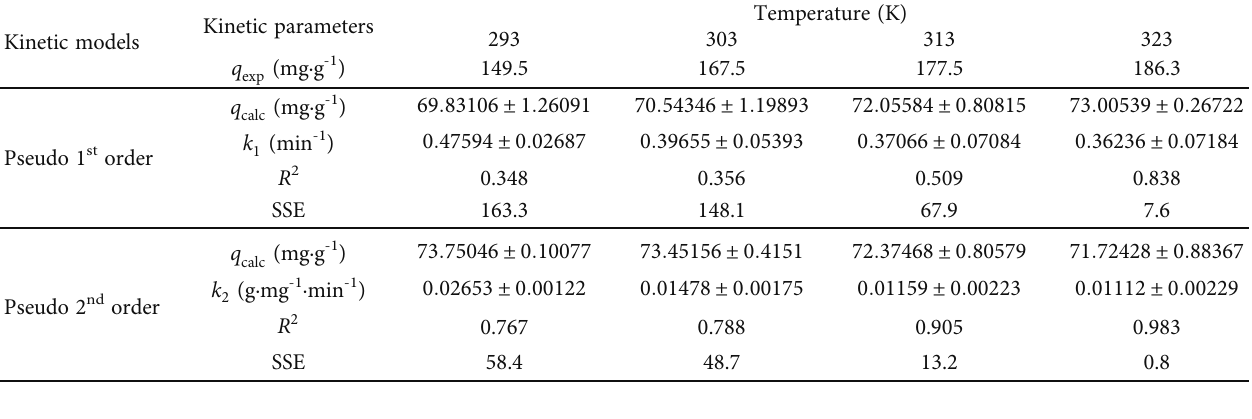
Table 1: Kinetic model parameters for the adsorption of BF on TKC.